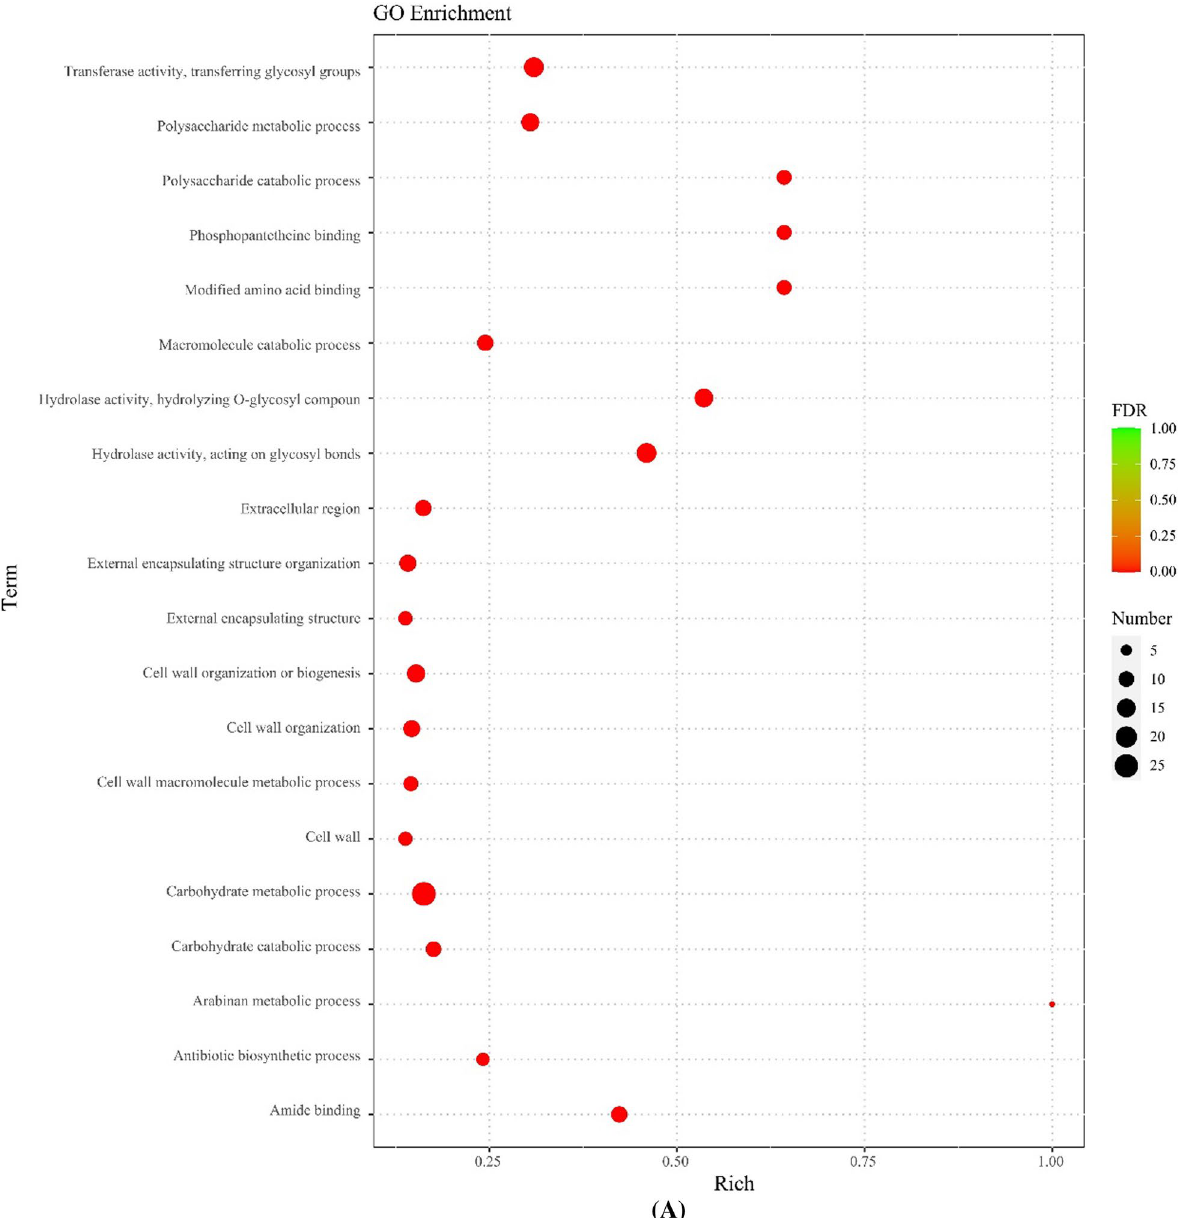
Fig. 2 Gene ontology (GO) enrichment analysis of differentially expressed genes in B. velezensis CL-4 between the FCGM-0 h and FCGM-48 h groups. A A bubble diagram and B bar chart show the results of the GO enrichment analysis. MF stands for molecular function, BP for biological processes, and CC for cellular